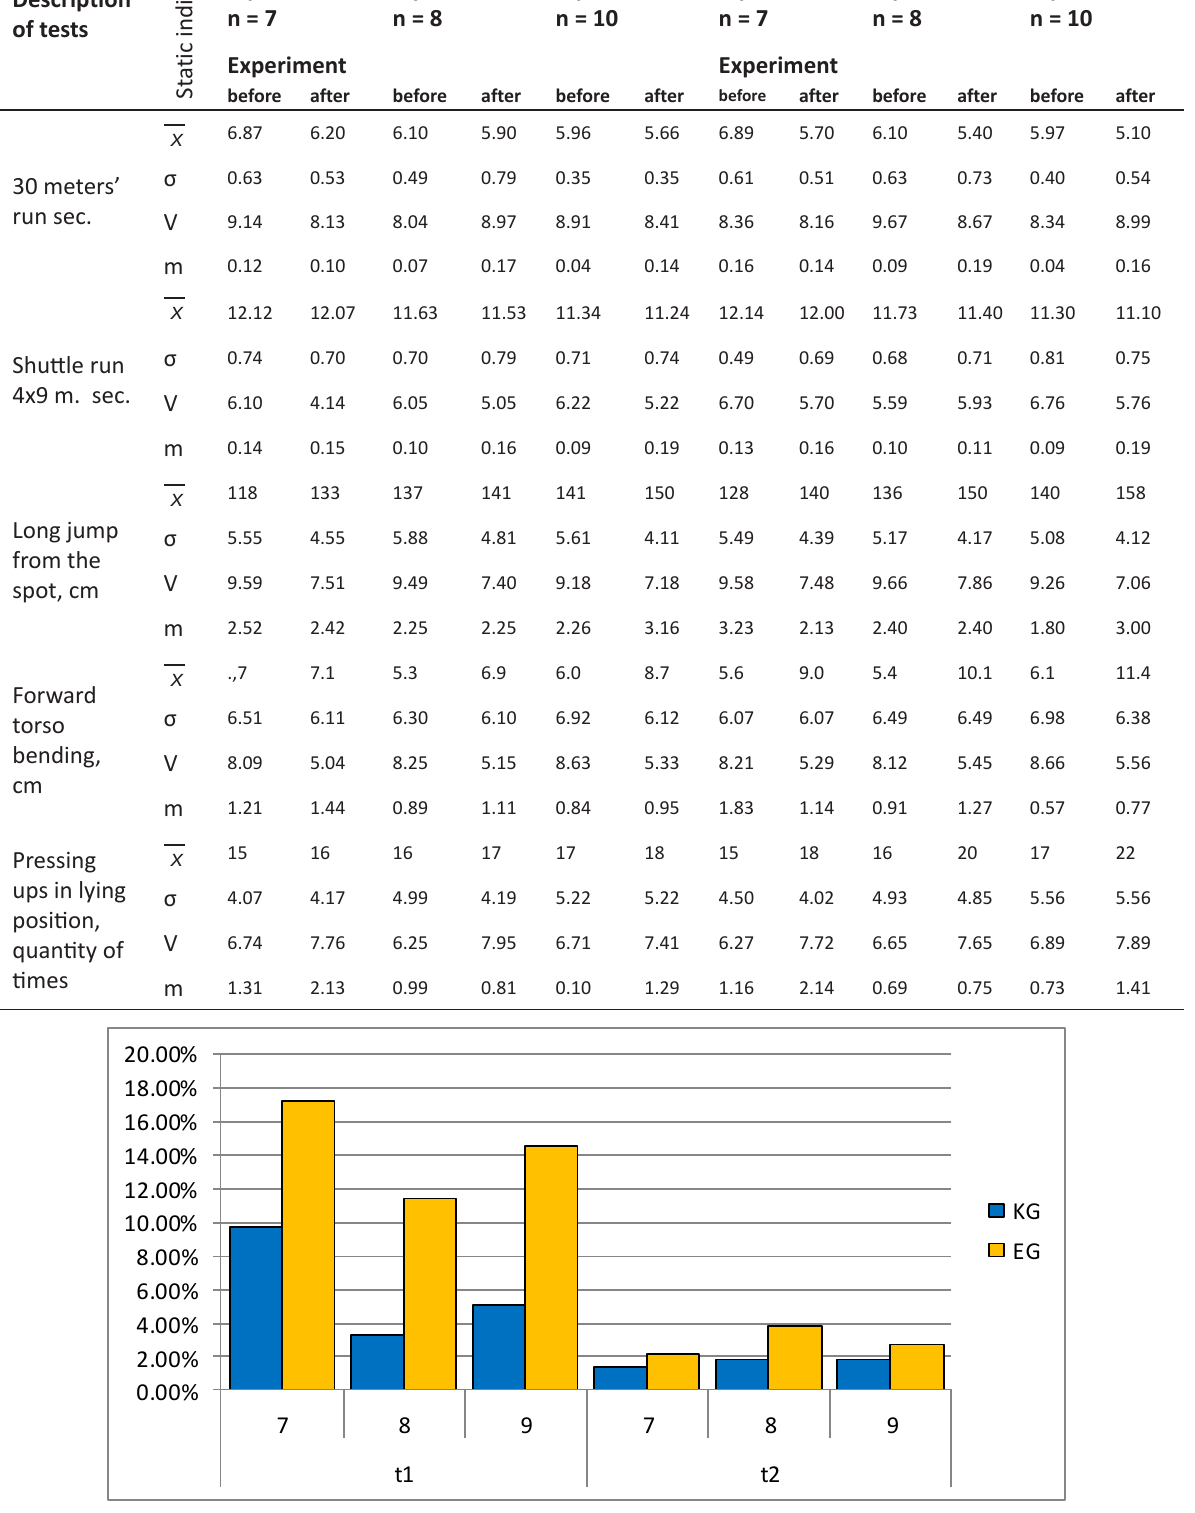
Table 1. Static indicators of 7-9 yrs boys’ motor abilities before and after experiment Boys control group Boys experimental group Description of tests Experiment Experiment